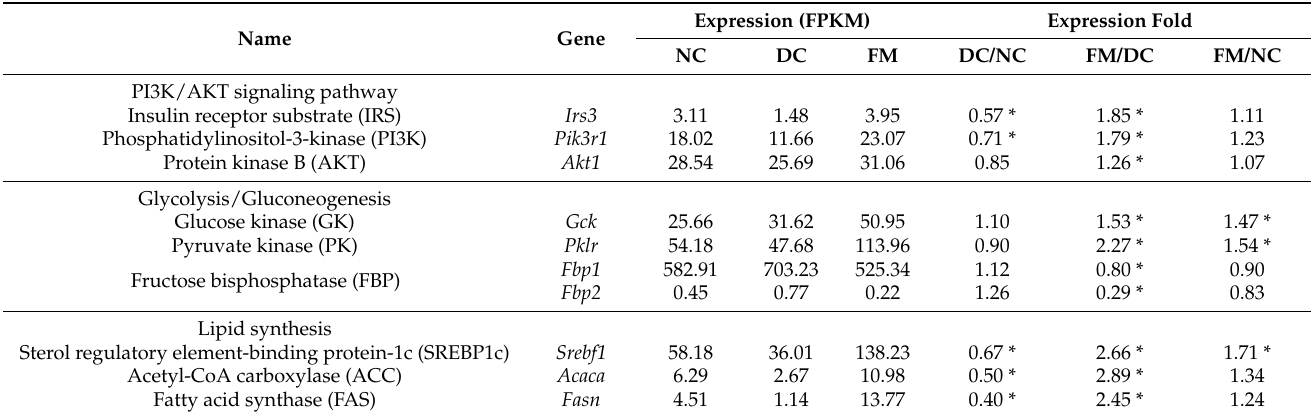
Table 1. Expression levels of key genes in PI3K/AKT signaling